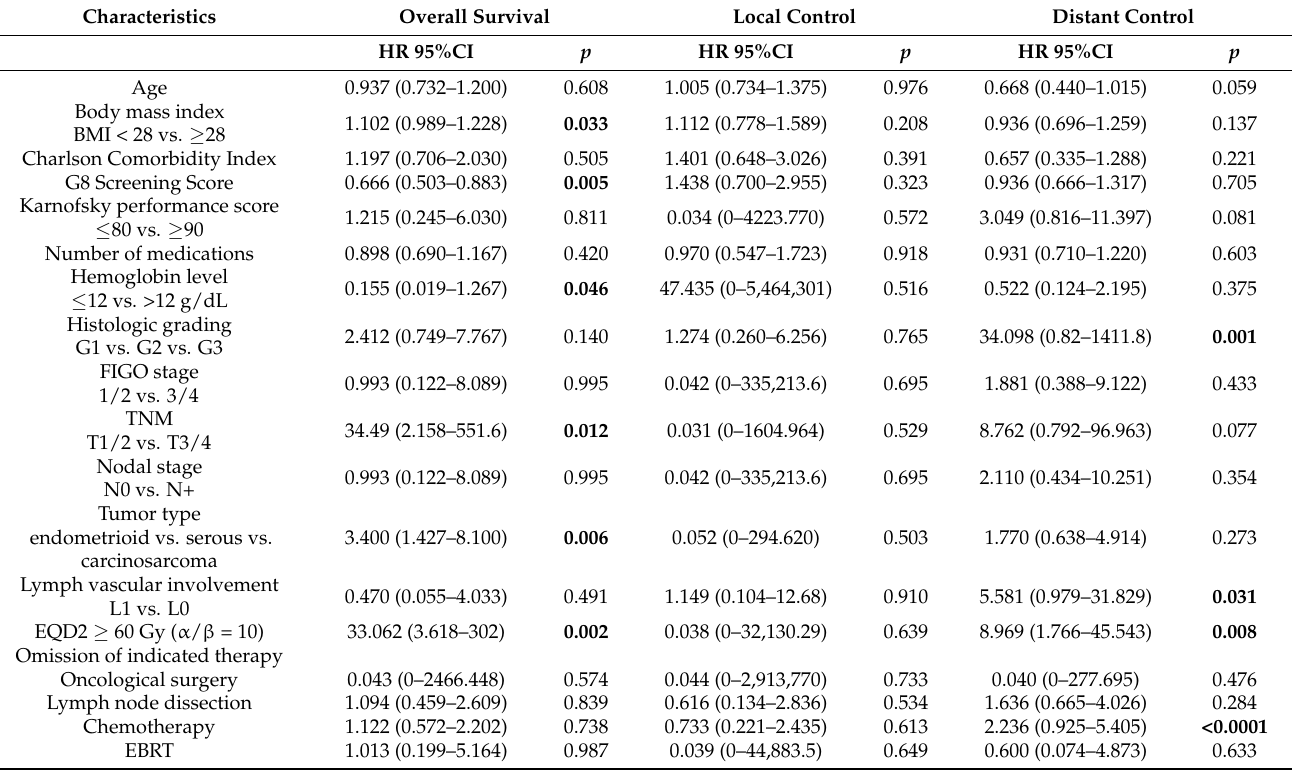
Table 4. Univariate analyses.